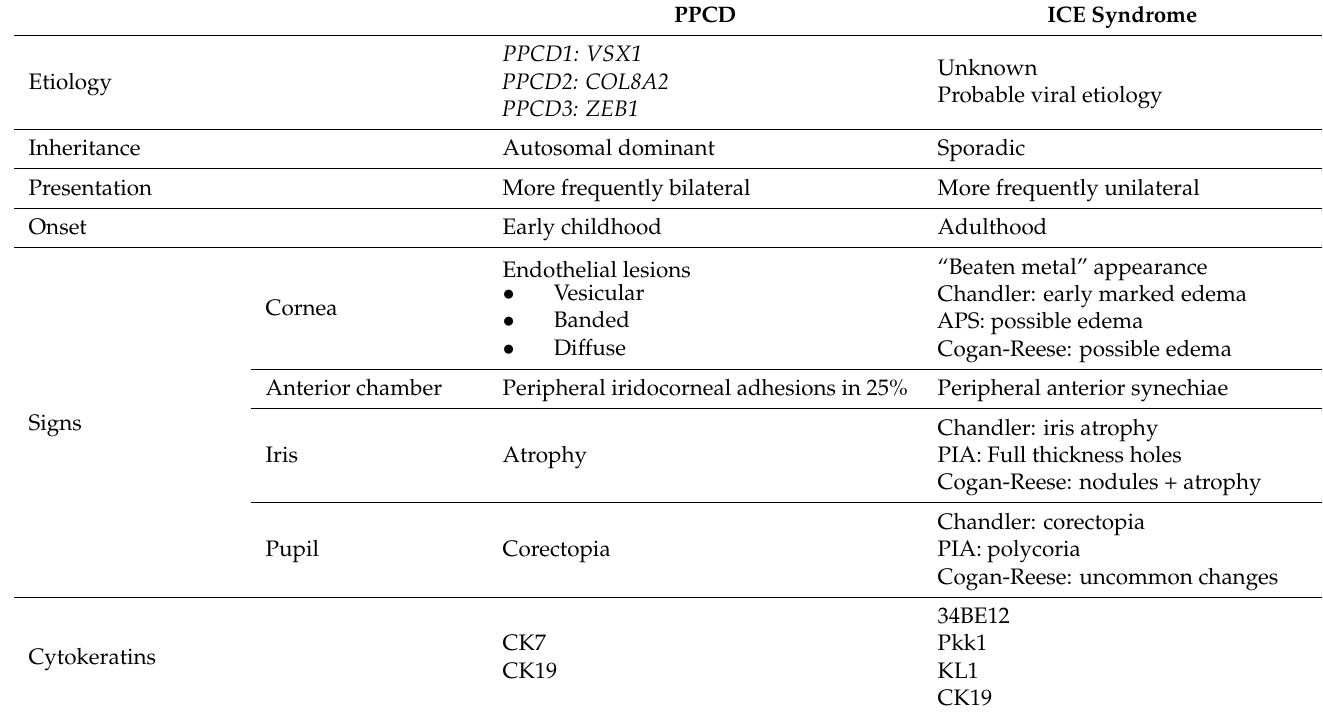
Table A1. The differential diagnosis of posterior polymorphous corneal dystrophy and iridocorneal endothelial